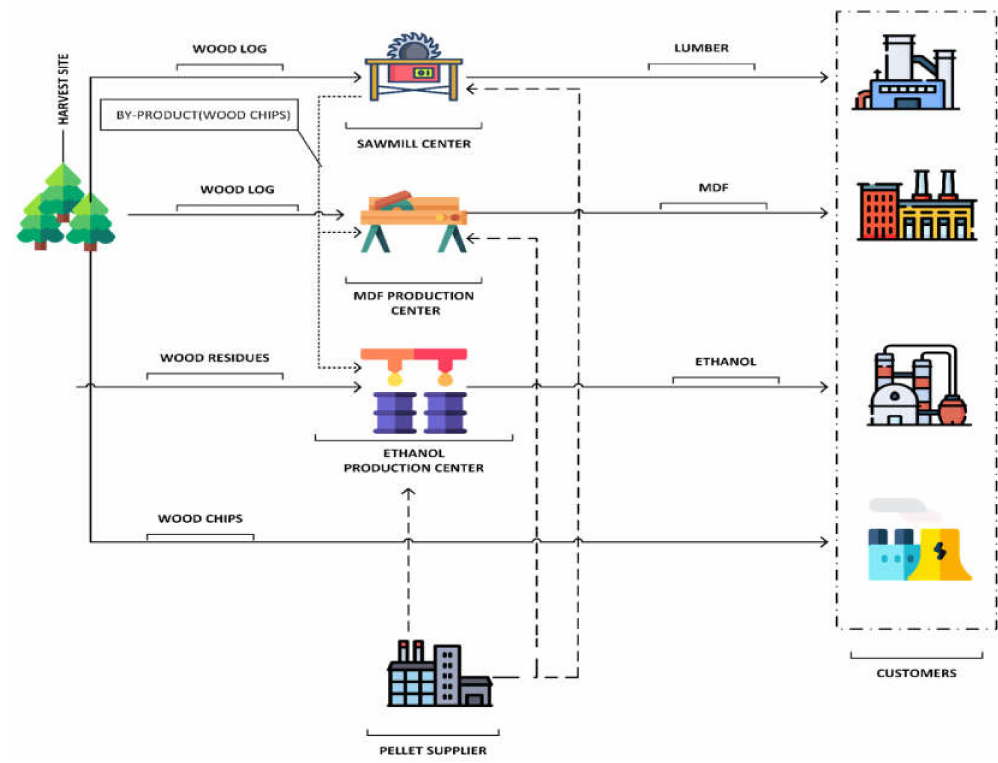
Figure 1. Presented forest supply chain network.